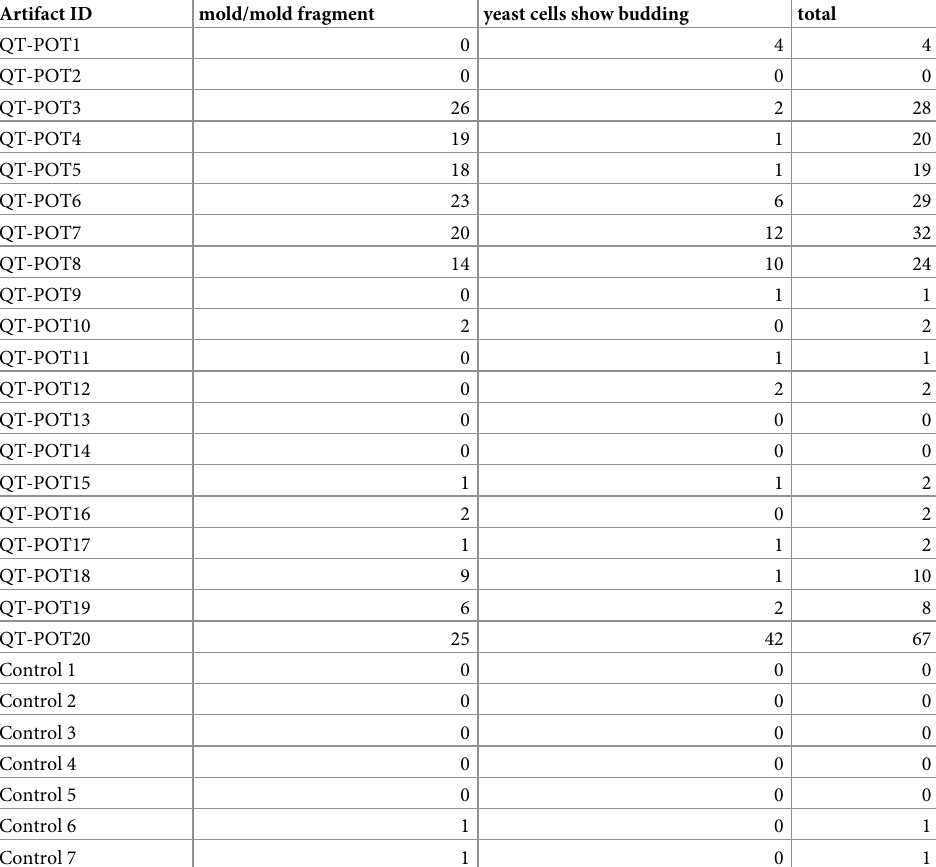
Table 2. Fungal elements from Qiaotou pottery and control